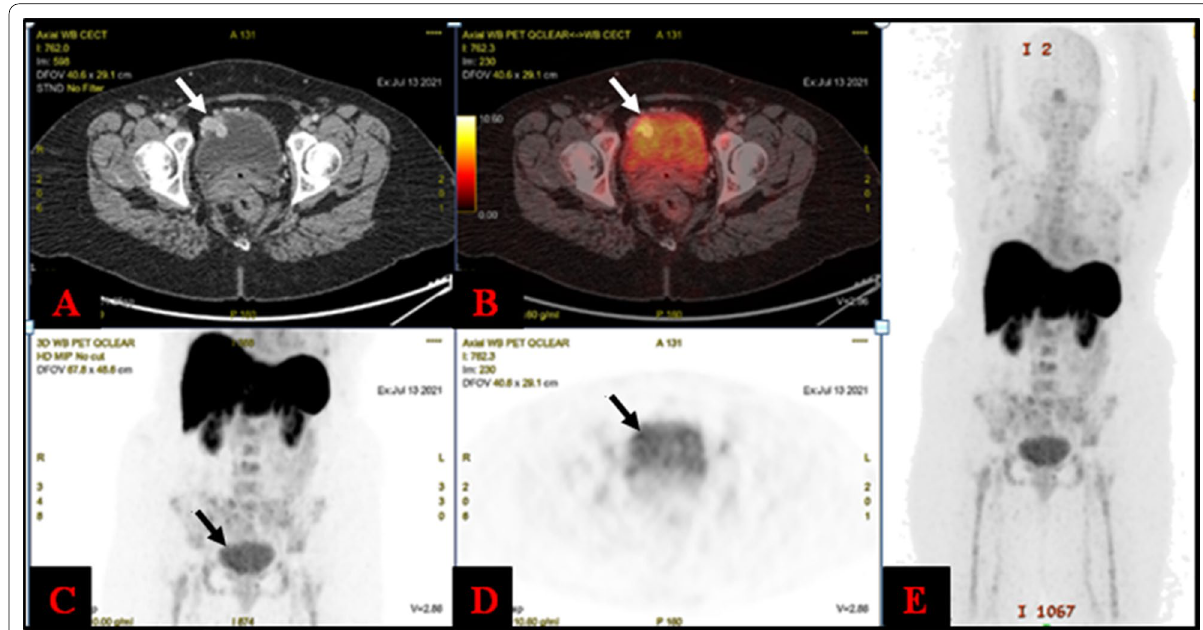
Fig. 4 On Ga DOTANOC PET/CT images ( A , B ) enhancing bladder mass lesion was seen (white arrow) but does not exhibit any increased tracer uptake. Corresponding maximum intensity projection images ( C , D ) reveal there was physiological tracer excretion and no significant uptake in the lesion (black arrow), and no somatostatin receptor-positive lesions elsewhere in the body ( E )